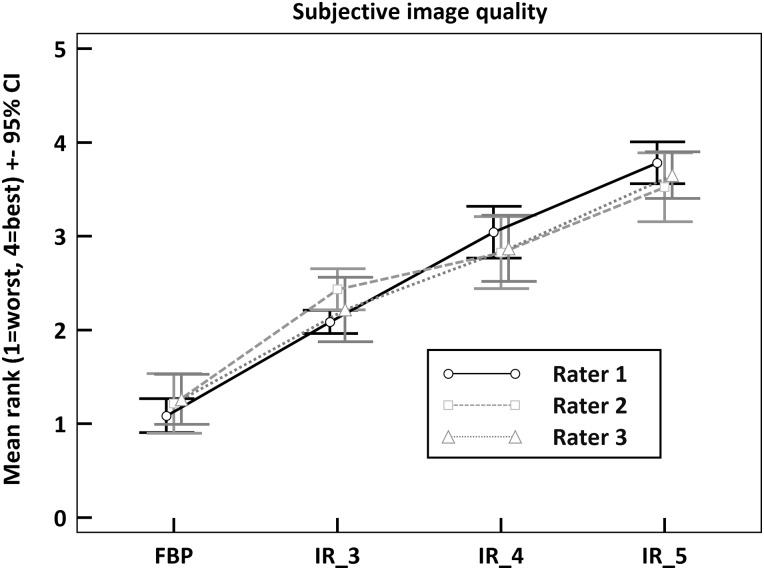
Subjective image quality.Overall subjective image quality of CTP maps ranked by 3 raters (1 = worst, 4 = best). CTP images for each patient acquired with FBP and IR levels 3–5 were rated independently by 3 raters in terms of overall image quality (image noise, amount of error voxels, visibility of ischemic lesion). 95% CI are displayed for the mean rank assigned by a rater to the respective reconstruction method (FBP vs. IR levels 3–5.) All IR levels were ranked significantly higher than FBP (p<0.05).